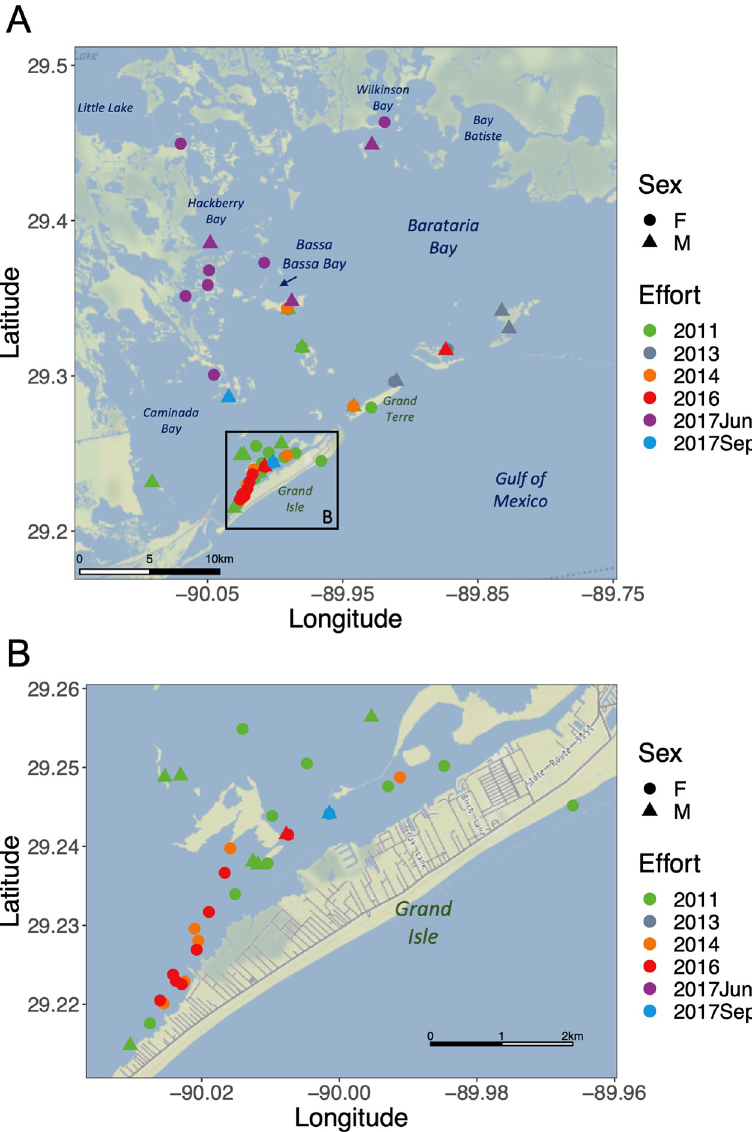
Fig 1. Capture/Release locations for all dolphins with satellite-linked telemetry tags in the Barataria Basin, LA from 2011 to 2017. (A) The June 2017 field effort was designed specifically to investigate dolphins near or north of Bassa Bassa Bay (purple), while the other efforts typically focused on dolphins near the barrier islands, especially Grand Isle (B). Map tiles used with permission from Stamen Design, under a CC BY license. Data by OpenStreetMap, under